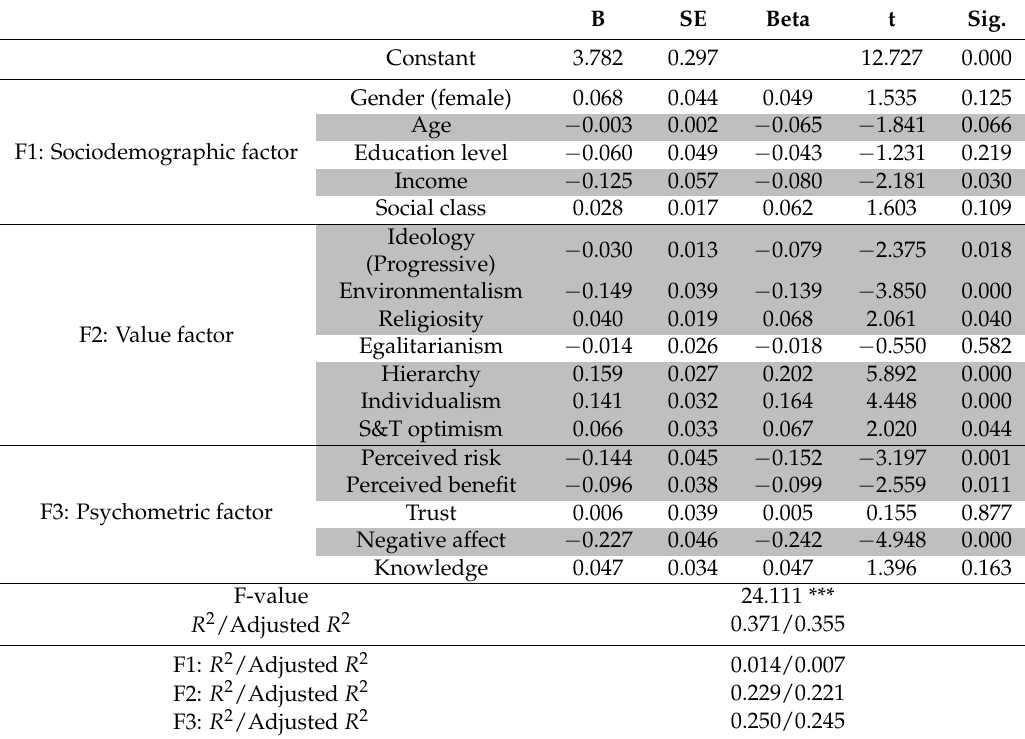
Table 4. Multiple linear regression analysis of climate change